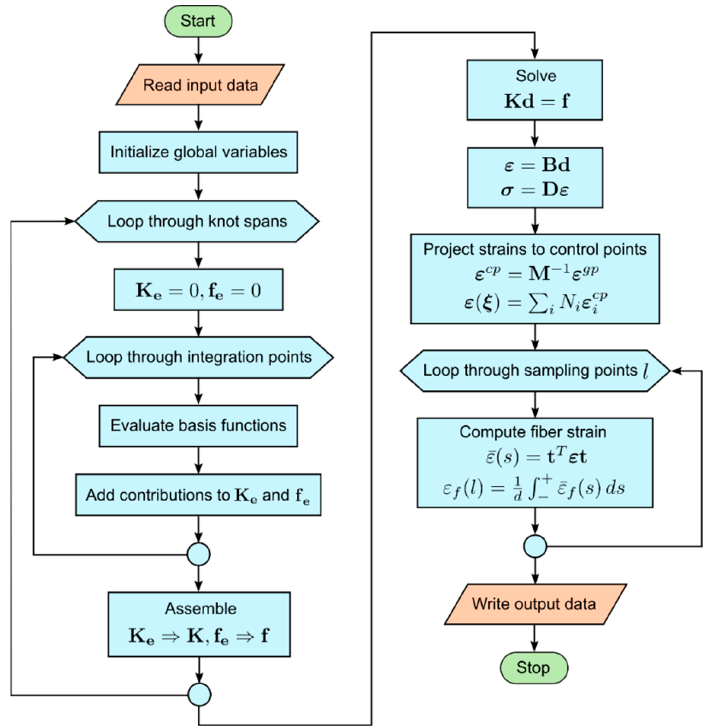
Figure 5. Flow chart for IGA elastic stress analysis and calculation of fiber strains.